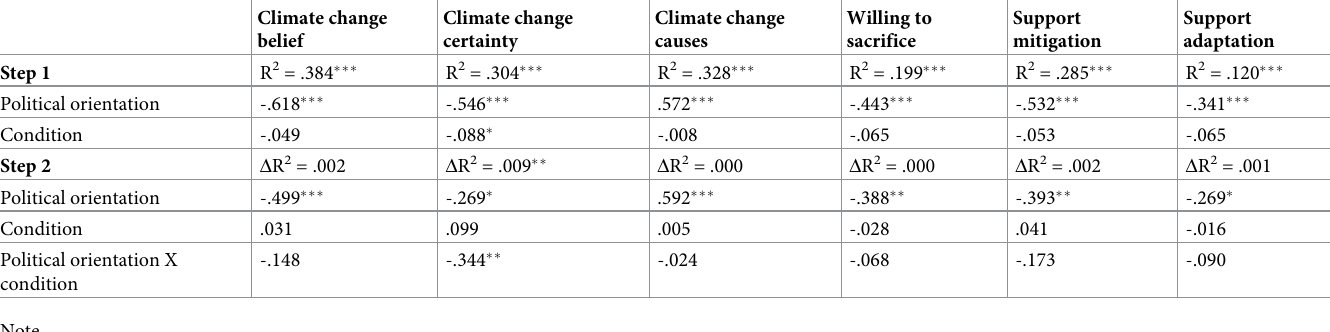
Table 1. Standardized regression coefficients regressing each DV on political orientation, condition, and the interaction term. Climate change